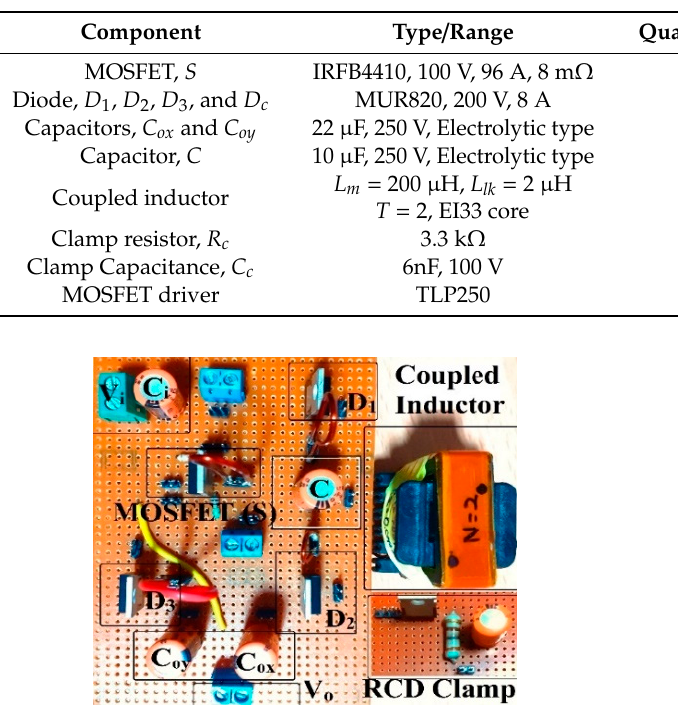
Figure 12. Experimental prototype of the proposed converter. Figure 13. Experimental prototype of the proposed